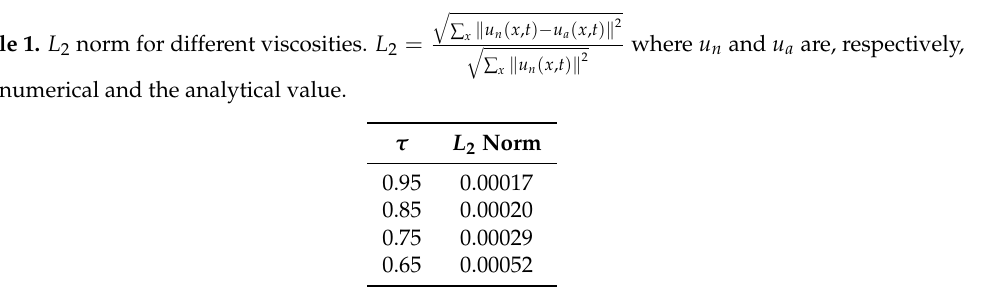
Figure 3. Velocity profiles for different relaxation times τ = 0.95, 0.85, 0.75, 0.65.